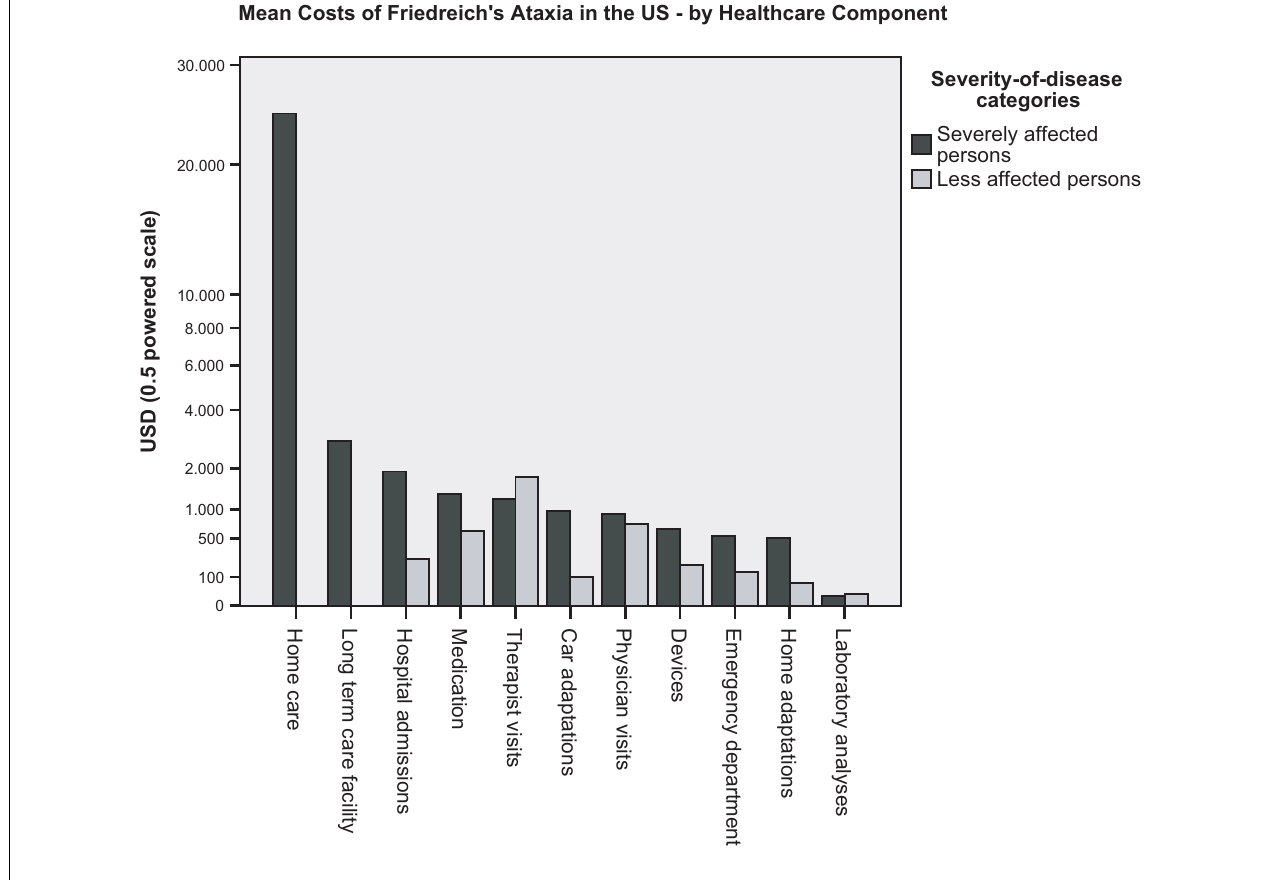
FIGURE 2 | US survey: mean costs of persons with FRDA, by healthcare component and severity of disease category .